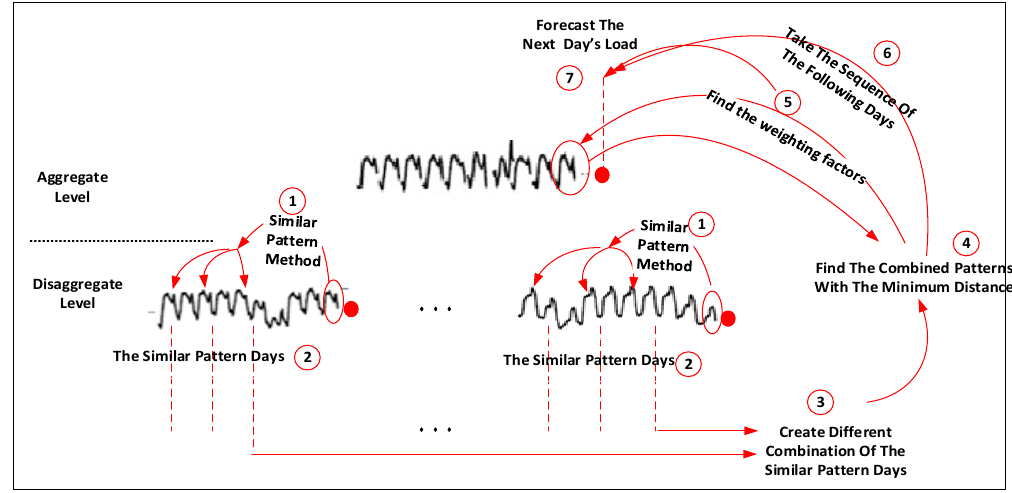
Figure 9. Schematic diagram of the proposed hybrid method.